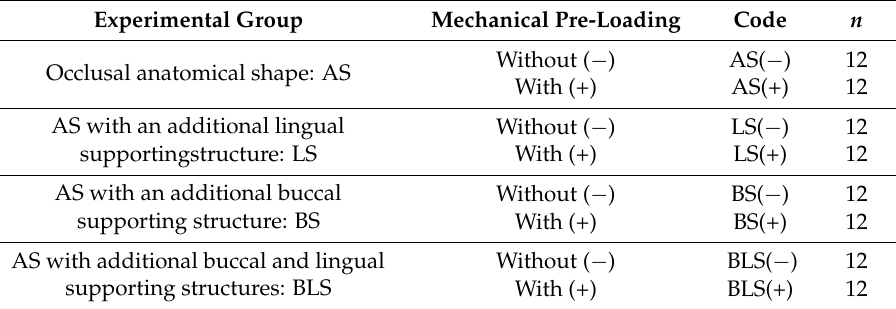
Table 1. Experimental groups in this study.